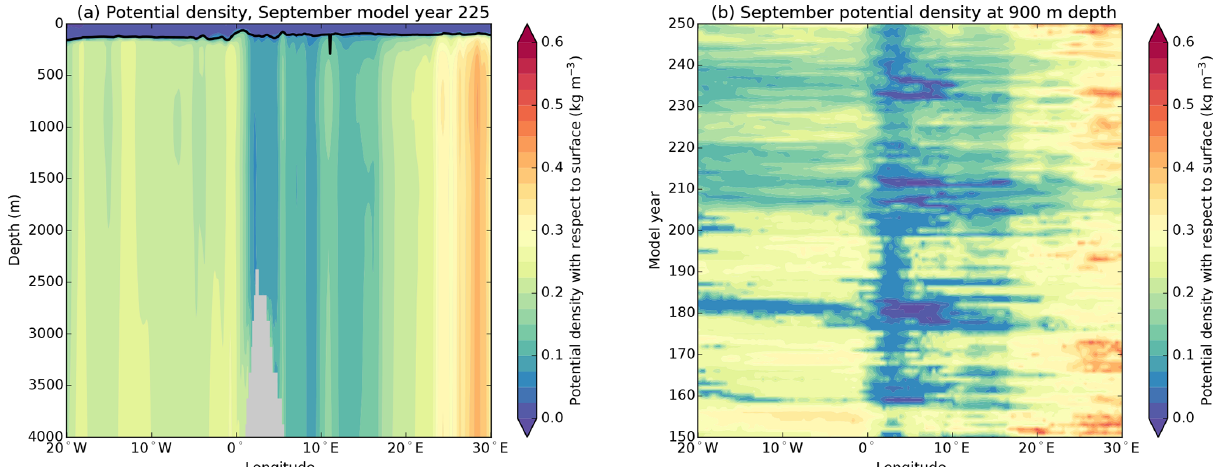
Figure 10. (a) Potential density across Maud Rise for September, model year 225. The black curve displays the monthly maximum mixed layer depth of that month. (b) Hovmöller diagram of the September potential density at 900m depth. The potential density and maximum mixed layer depth are meridionally averaged between 65 and 64 ◦